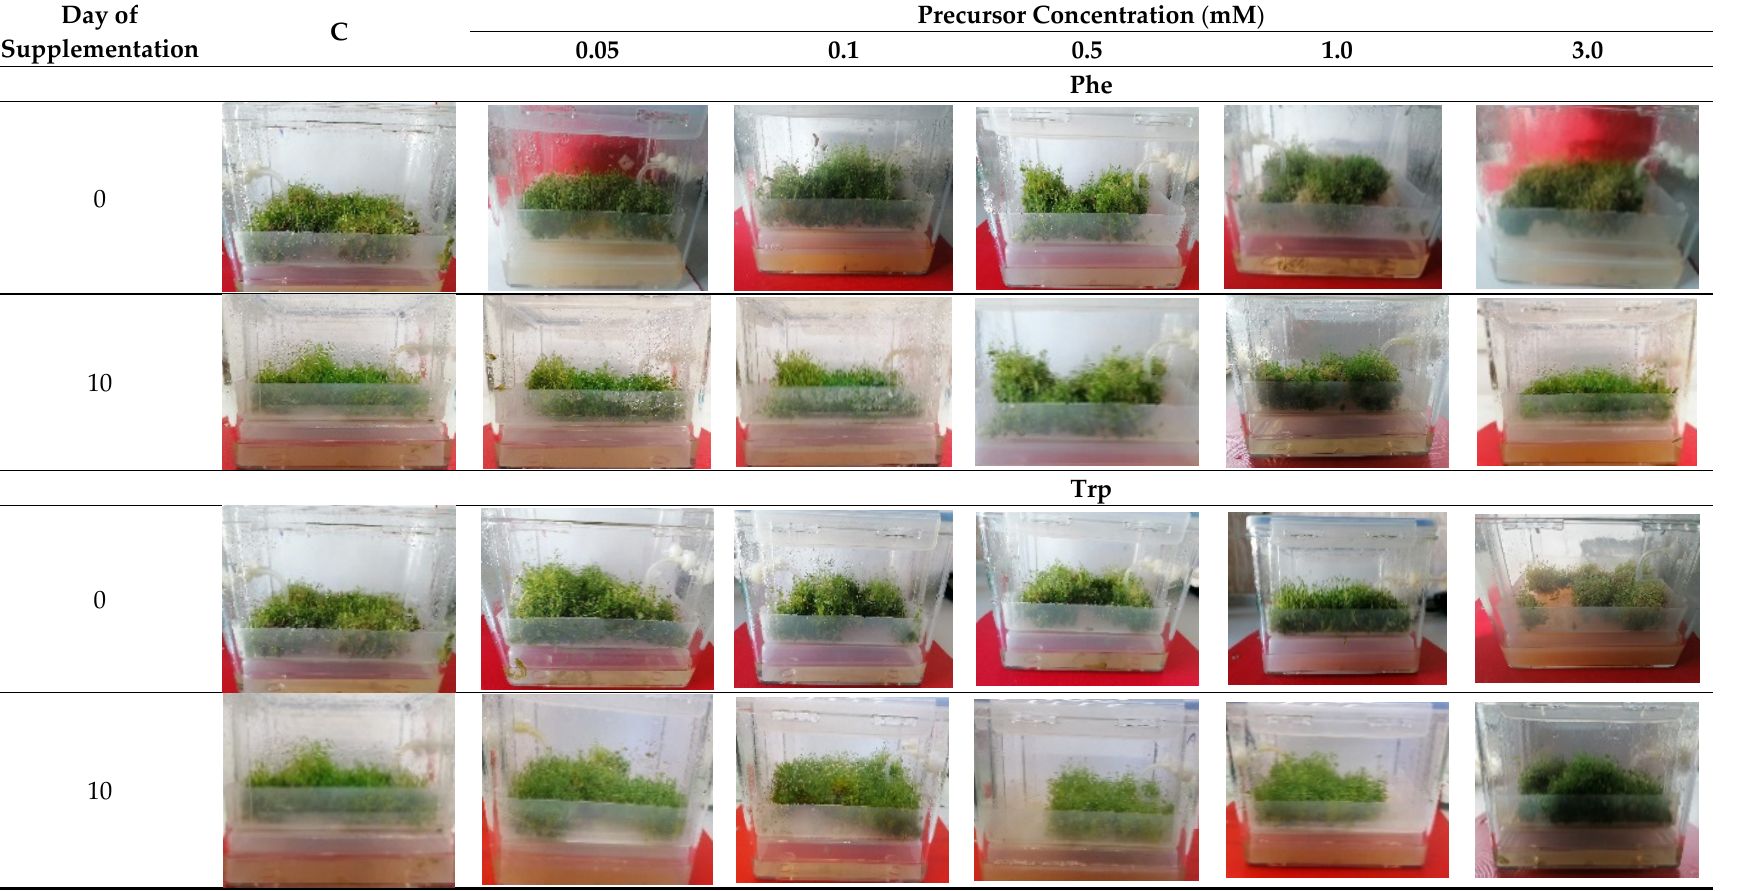
Figure 1. Morphological appearance of Plantform bioreactor-grown N. officinale microshoot cultures after precursor feeding.